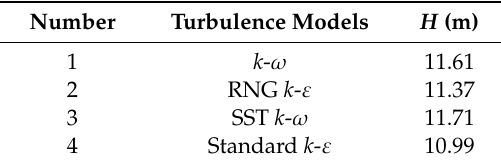
Table 5. Performance results with di ff erent turbulence models under design flow rate condition. Number Turbulence